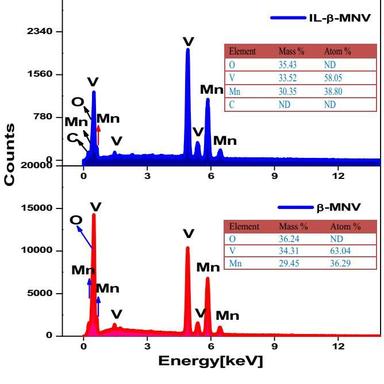
EDAX spectra of β-MNV and IL-β-MNV.